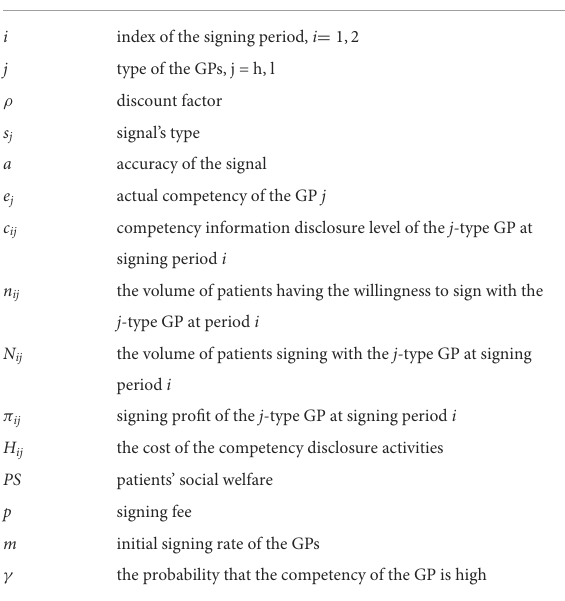
TABLE 1 Notations for variables and